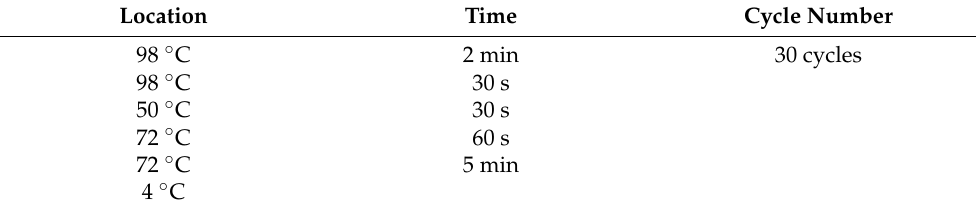
Table 1. PCR amplification